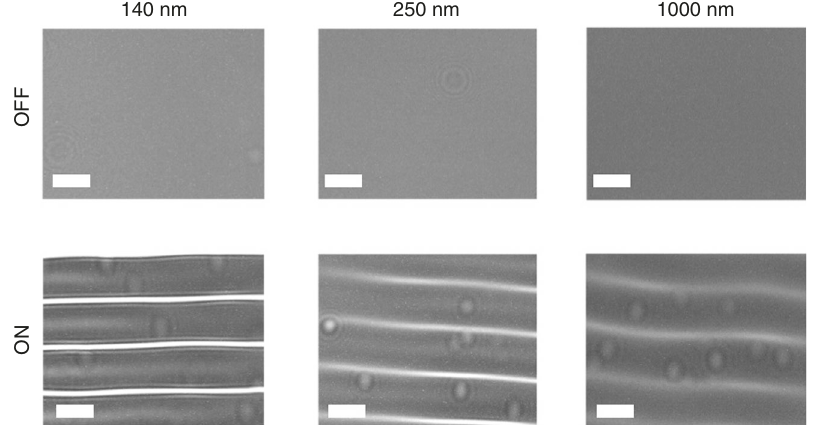
Fig. 6 Nanoparticle detection experiments with and without SAW. Images of 140 – 1000 nm nanoparticles are reported. Without SAW there is no standing wave and the nanoparticles cannot be detected by the CMOS image sensor. Application of SAW creates a thin fi lm meniscus around the nanoparticles and so their lens-free holograms can be detected. The scale bar in all images is 100 μ